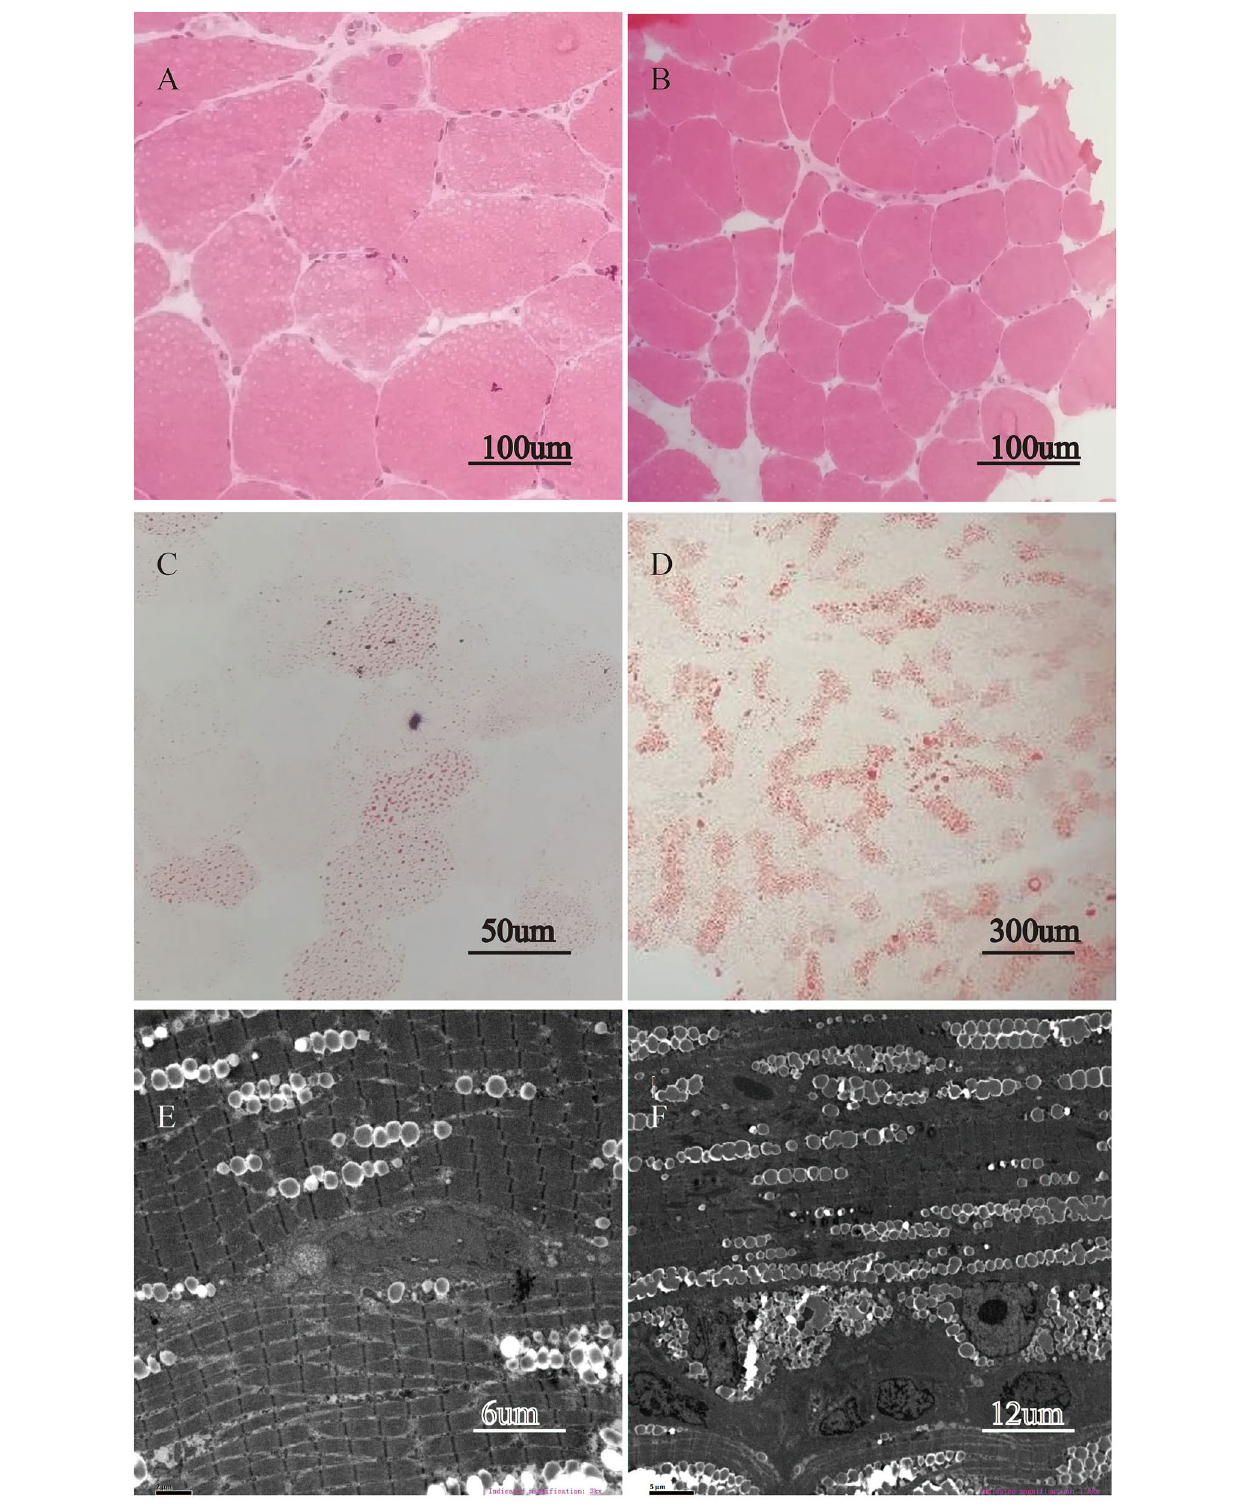
FIGURE 1 | Lipid storage in quadriceps femoris muscle biopsy. H&E stain revealed intracytoplasmic vacuoles appearing in most fibers of patient 2 ( A , magnification × 400) and patient 3 ( B , magnification × 200). ORO stain demonstrated abnormal accumulation of lipid droplets in muscle tissue of patient 2 ( C , magnification × 400), and of patient 3 ( D , magnification × 60). The electron microscopic ultrastructural muscle fiber study reveals the substantial deposition of lipid droplets between myofibrils in patient 2 ( E , magnification × 3,000) and in patient 3 ( F , magnification × 1,500).